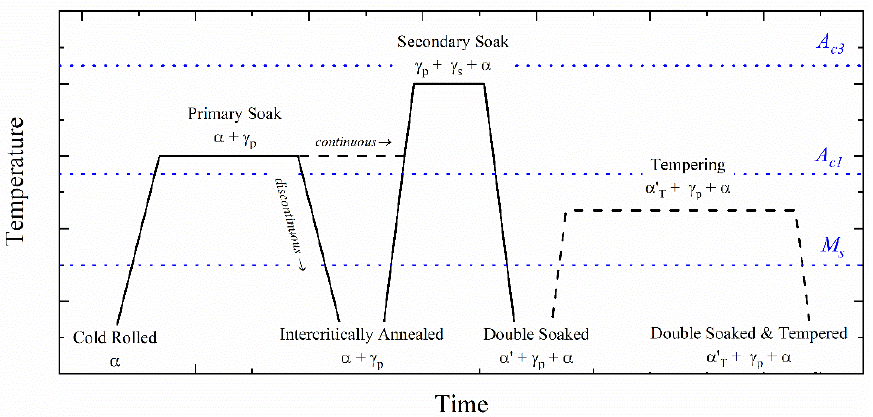
Figure 1. Schematic of the double soaking and double soaking plus tempering heat treatment. Expected changes in microstructure are indicated: Ferrite (α), primary austenite ( 𝛾 𝑃 ), secondary austenite ( 𝛾 𝑠 ), martensite (α') , and tempered martensite ( 𝛼 𝑇′ ).